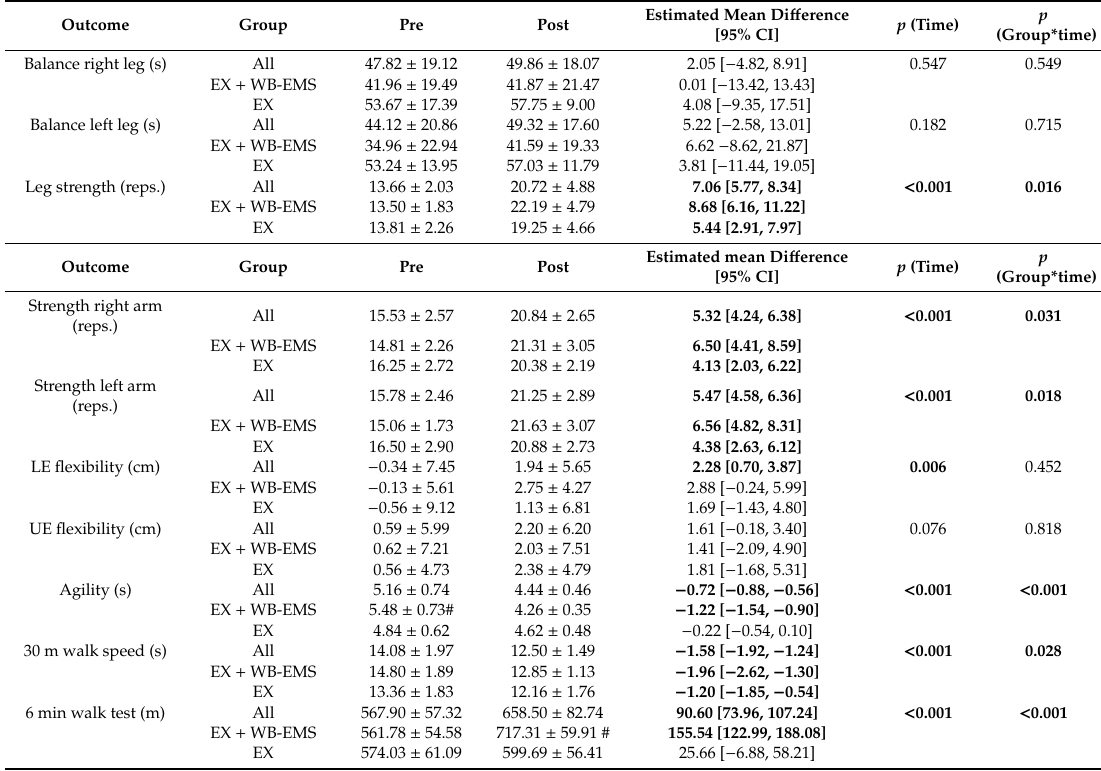
Data are presented as mean ± SD. LE: Lower Extremity. UE: Upper extremity. WB-EMS: Whole-body electromyostiulation. EX + WB-EMS: Voluntary exercise with WB-EMS; EX: Voluntary exercise group; Significant mean di ff erences and p -values ( p ≤ 0.05) are shown in bold; # p Bonferroni ≤ 0.05 di ff erent to EX group